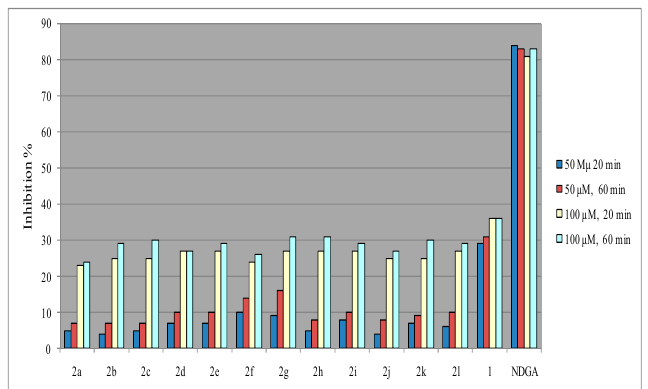
Figure 2. Effect of compounds 2 towards 2,2-diphenyl-2-picrylhydrazyl (DPPH).